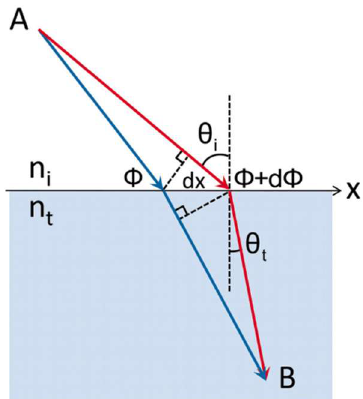
Figure 2. Schematic diagram for the derivation of generalized Snell’s law. Light travels between two points A and B. The red line and blue line represent two optical paths. From [24]. Reprinted with permission from AAAS.